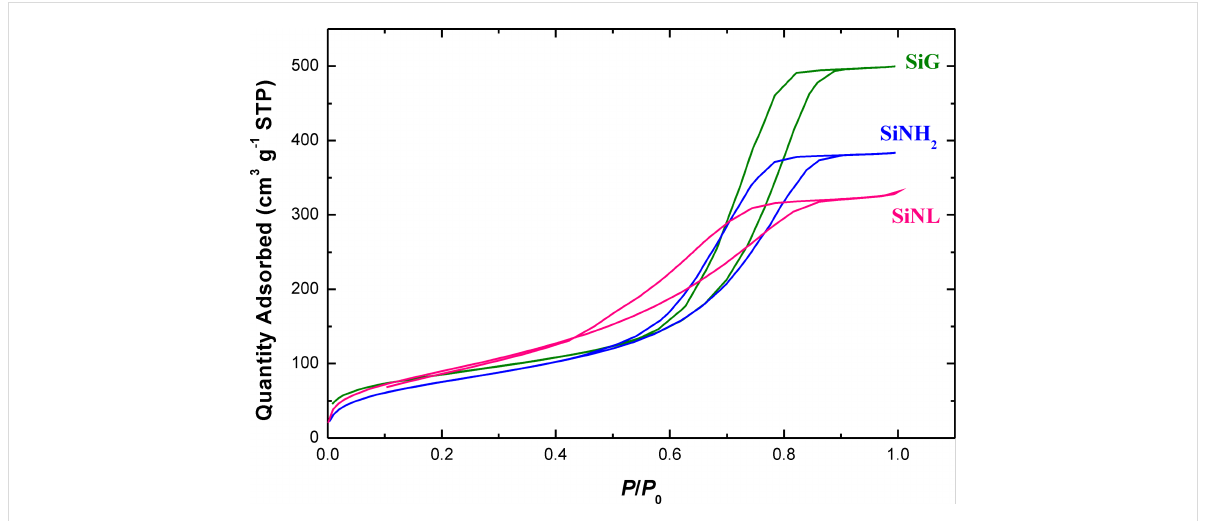
Figure 4: Nitrogen adsorption–desorption isotherm plots of SiG, SiNH 2 and SiNL.